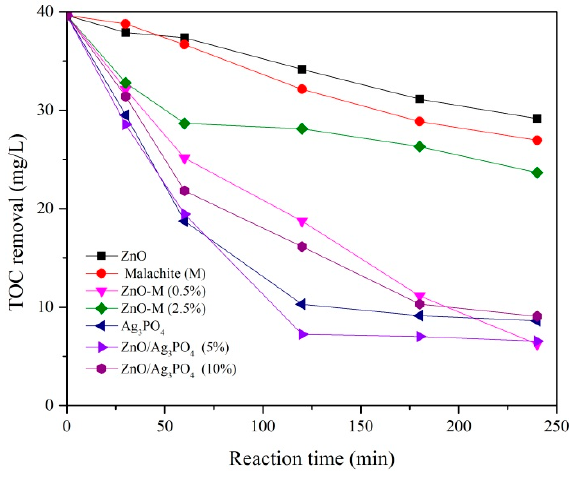
Figure 5. Total organic carbon content in the municipal wastewater samples before and after treatment. Table 3. Analysis of physicochemical parameters before and after photocatalytic treatment of munici- pal and handmade textile staining